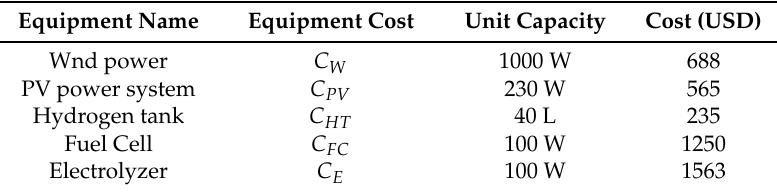
Table 1. Cost of Each Design Factor.